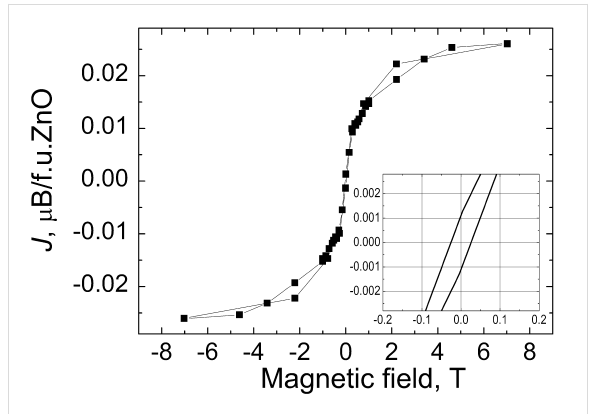
Figure 2: Magnetization (calibrated in units of Bohr magnetons per formula unit of ZnO) at RT for ZnO thin films doped with 0.1 atom % Fe deposited on the sapphire substrate. The curve was obtained after subtracting the magnetic contribution from the substrate and the sample holder. The inset shows the magnified central part of the magnetisation curve.